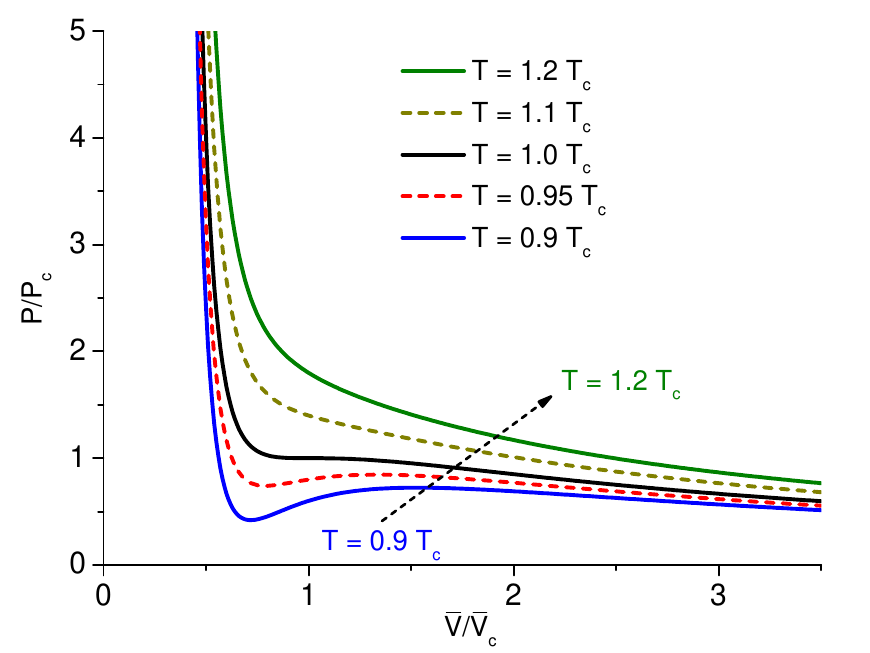
Figure 3. Pressure versus specific volume curves (normalized to P c and V c , respectively) for the van der Waals gas. The five curves (from bottom to top) correspond to fixed temperatures (0.9 T c , 0.95 T c ,